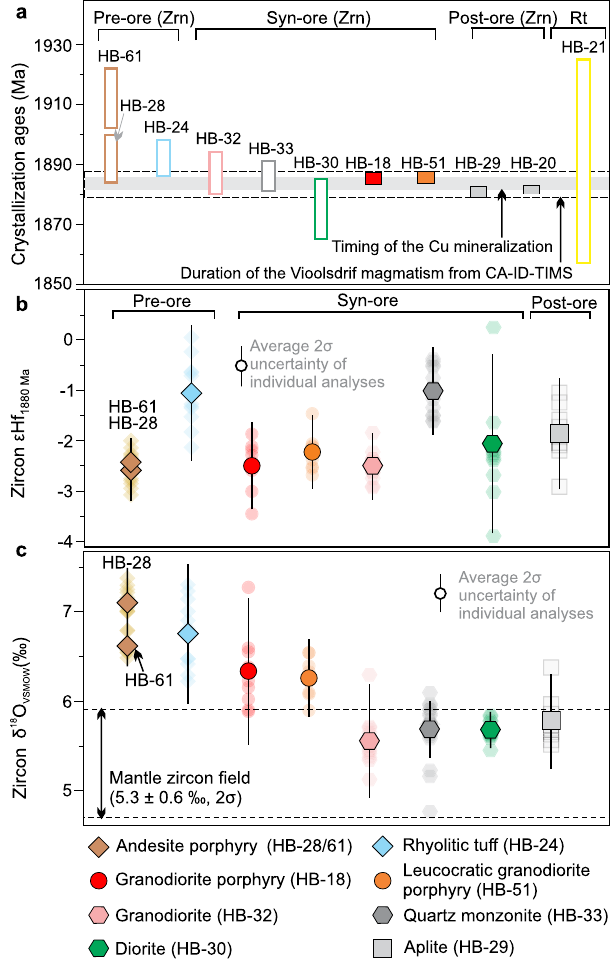
Fig. 3 Zircon U – Pb-Hf-O and rutile U – Pb isotopes for representative rocks in Haib. a Crystallization ages of magmatic zircons from ten pre-, syn-, and post-ore igneous rocks (identi fi ed from cross-cutting relationship, details in Supplementary Note 1) and a hydrothermal rutile (sample HB-21, syn-ore granodiorite porphyry) associated with chalcopyrite mineralization in Haib, dated using LA-ICP-MS (samples HB-61, HB-28, HB-24, HB-32, HB-33, and HB-30) and CA-ID-TIMS (samples HB-18, HB-51, HB-29, and HB-20) methods. b Zircon Hf isotopic composition (as ε Hf calculated at 1880 Ma). c Zircon δ 18 O ratios for representative igneous samples. Filled symbols in ( b ) and ( c ) are average values for each sample; smaller pale symbols represent individual analyses. Mantle zircon fi eld in ( c ) is from ref. 85 . Error bars indicate 2 σ uncertainties. See Supplementary Data 1 for sample locations and descriptions.